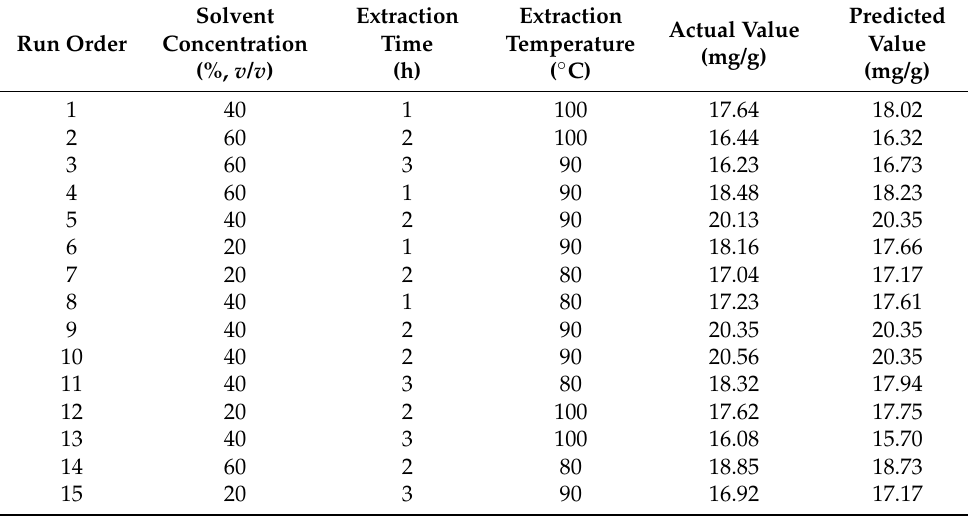
Table 3. Central composition design and response values of the CA yield of the D. morbifera leaves